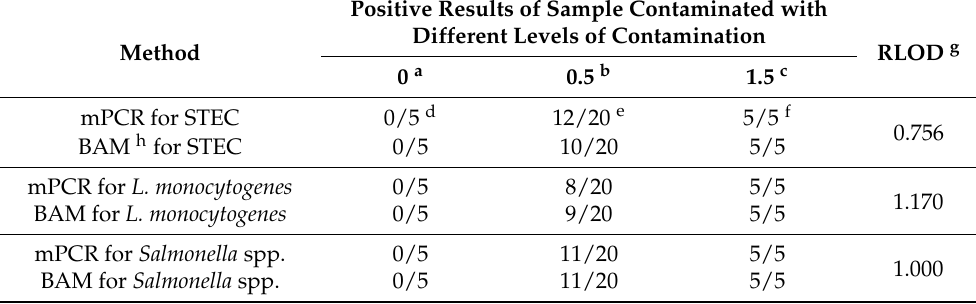
mPCR for Salmonella